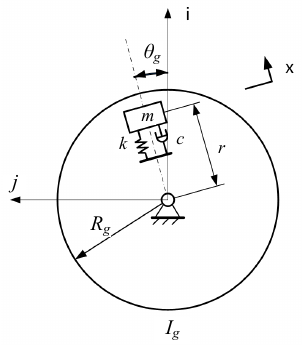
Figure 2. Motion description of the internal resonance vibration absorber.